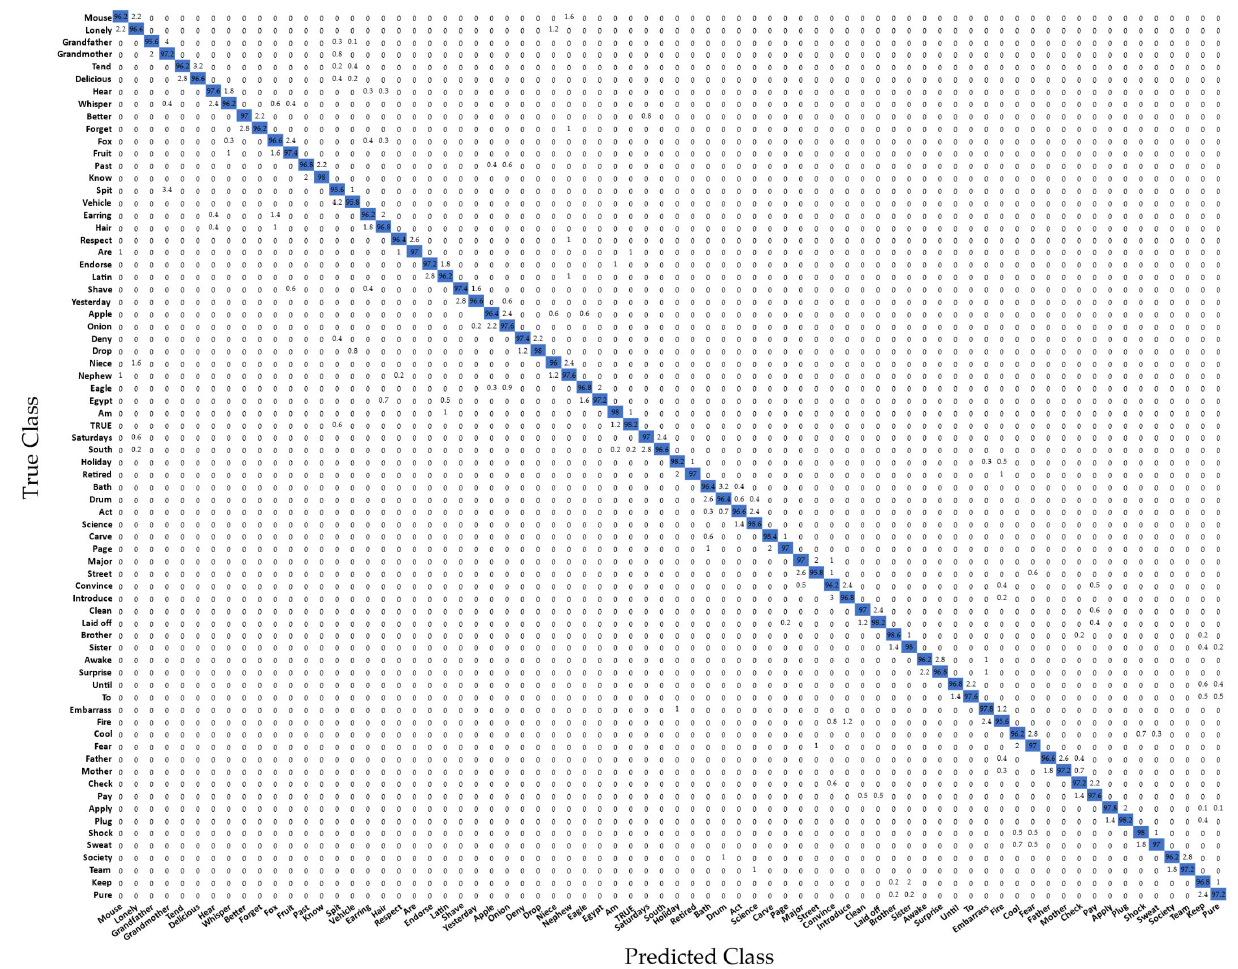
Figure 14. Confusion matrix of the recognition performance of 72 American Sign Language (ASL) words.